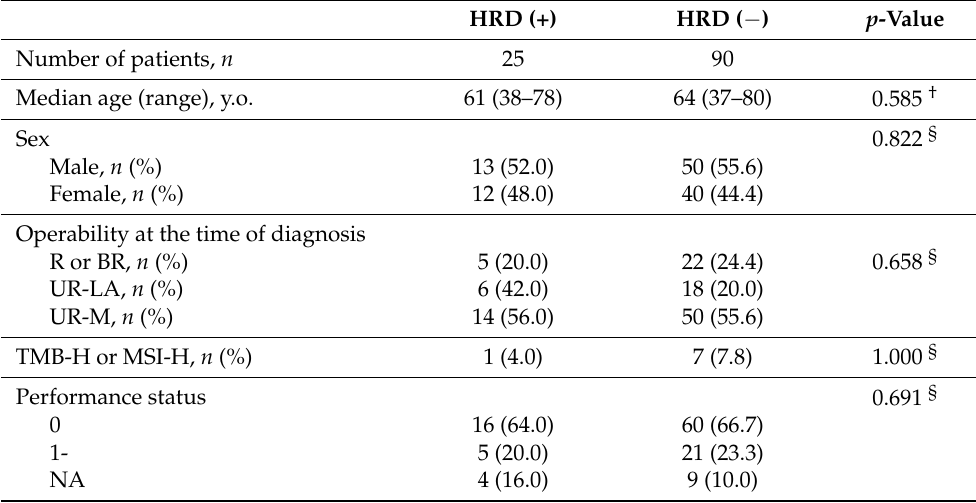
Table 3. Comparison of patient characteristics between the patients who had homologous recombina- tion deficiency (HRD)-related genetic mutations (HRD (+)) and those who did not (HRD ( − )). HRD (+) HRD ( − ) p -Value Number of patients, n Median age (range),